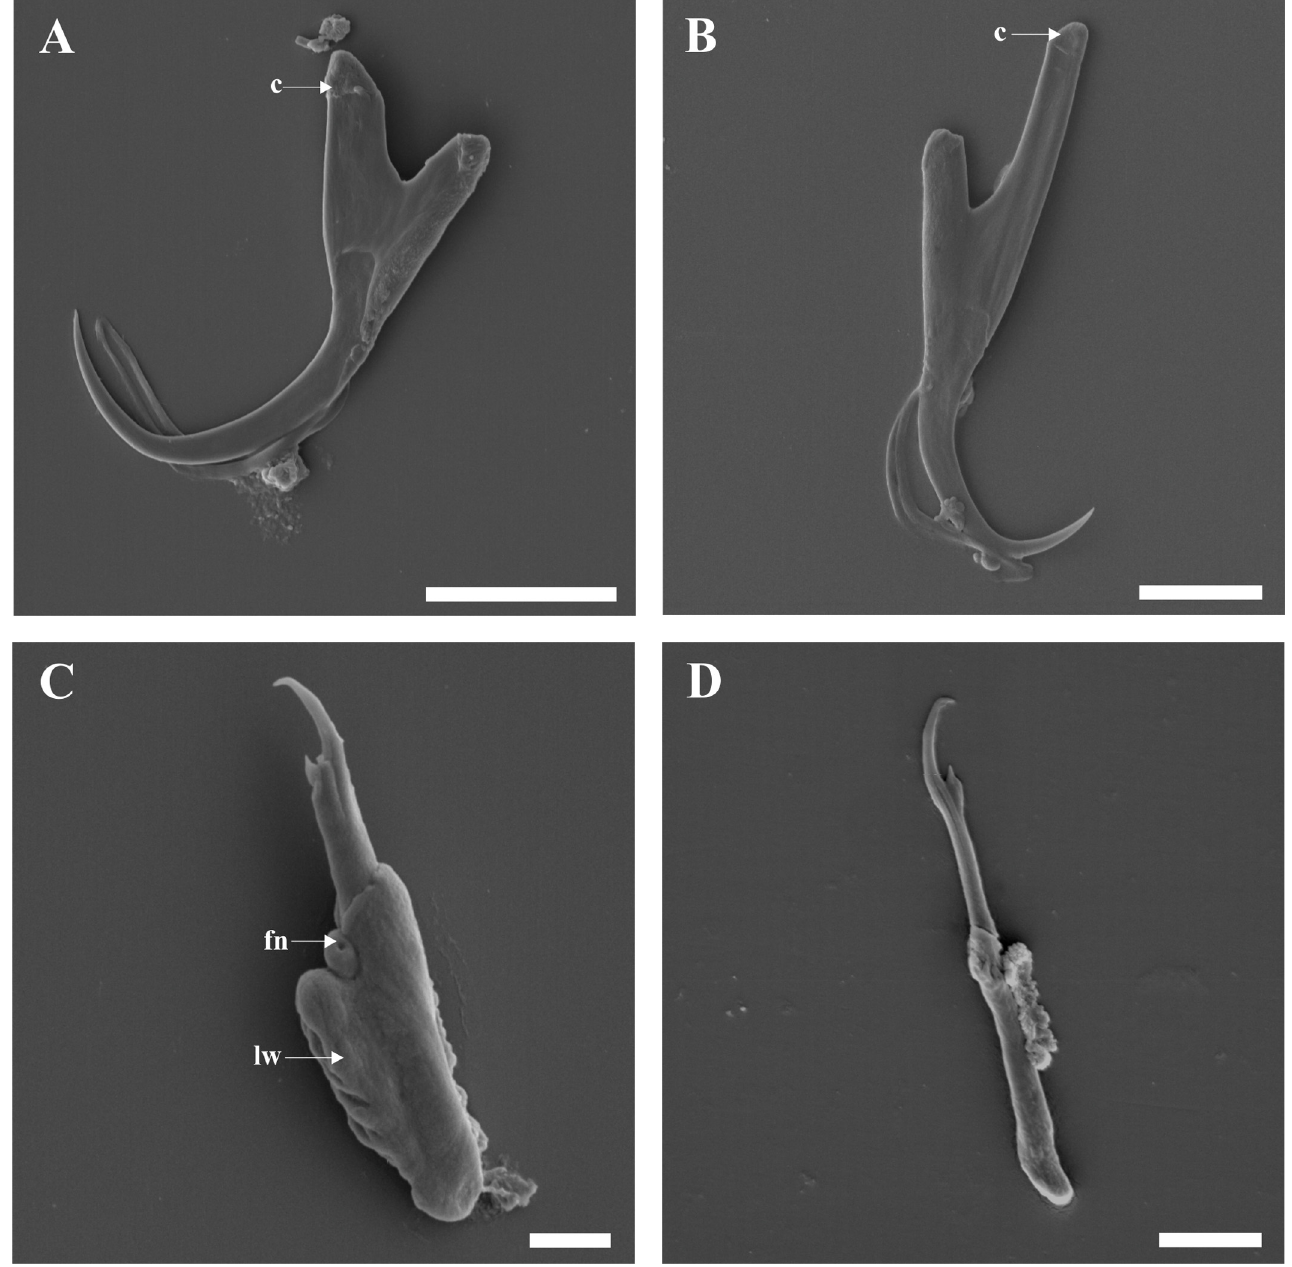
Figure 5. SEM micrographs of gripi (anchors) and uncinuli (hooklets): A ventral gripus: B dorsal gripus; C marginal hooklet I; D marginal hook. Abbreviations: c cap; fn fenestration; lw lateral wing. Scale-bars: A, B 10 m m;C, D 5 m